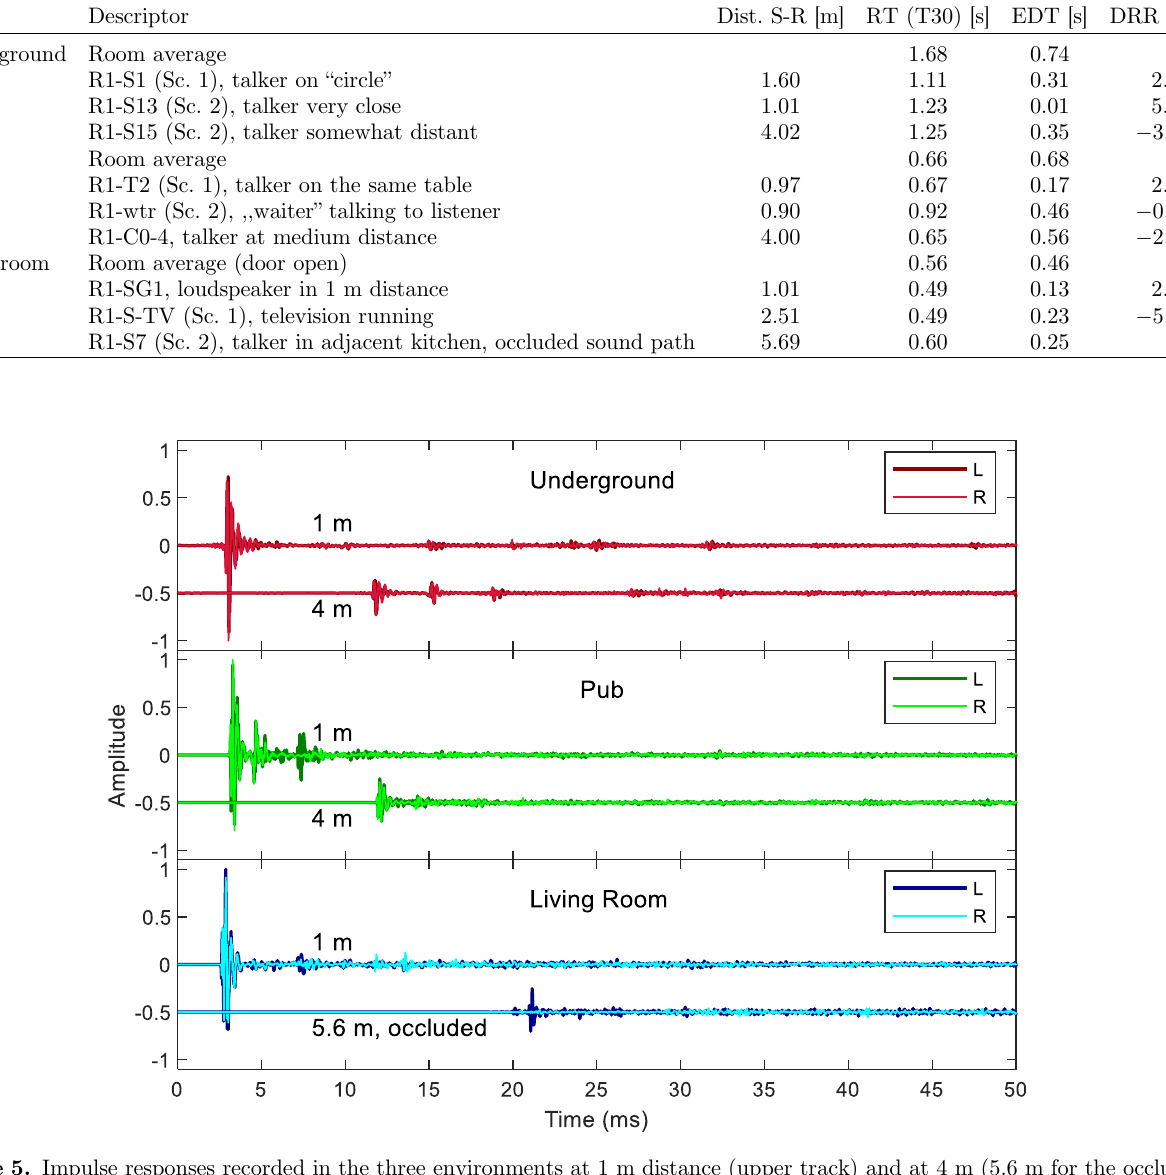
Figure 5. Impulse responses recorded in the three environments at 1 m distance (upper track) and at 4 m (5.6 m for the occluded path in the Living room) distance (lower track, offset by (cid:1) 0.5) as shown in Table 1. All impulse responses were normalized to the maximum of the 1-m condition. The distance-related amplitude reduction can be observed in the lower tracks. Note that for better readability the lower track in the Living room lab (lower panel) was scaled up by a factor of